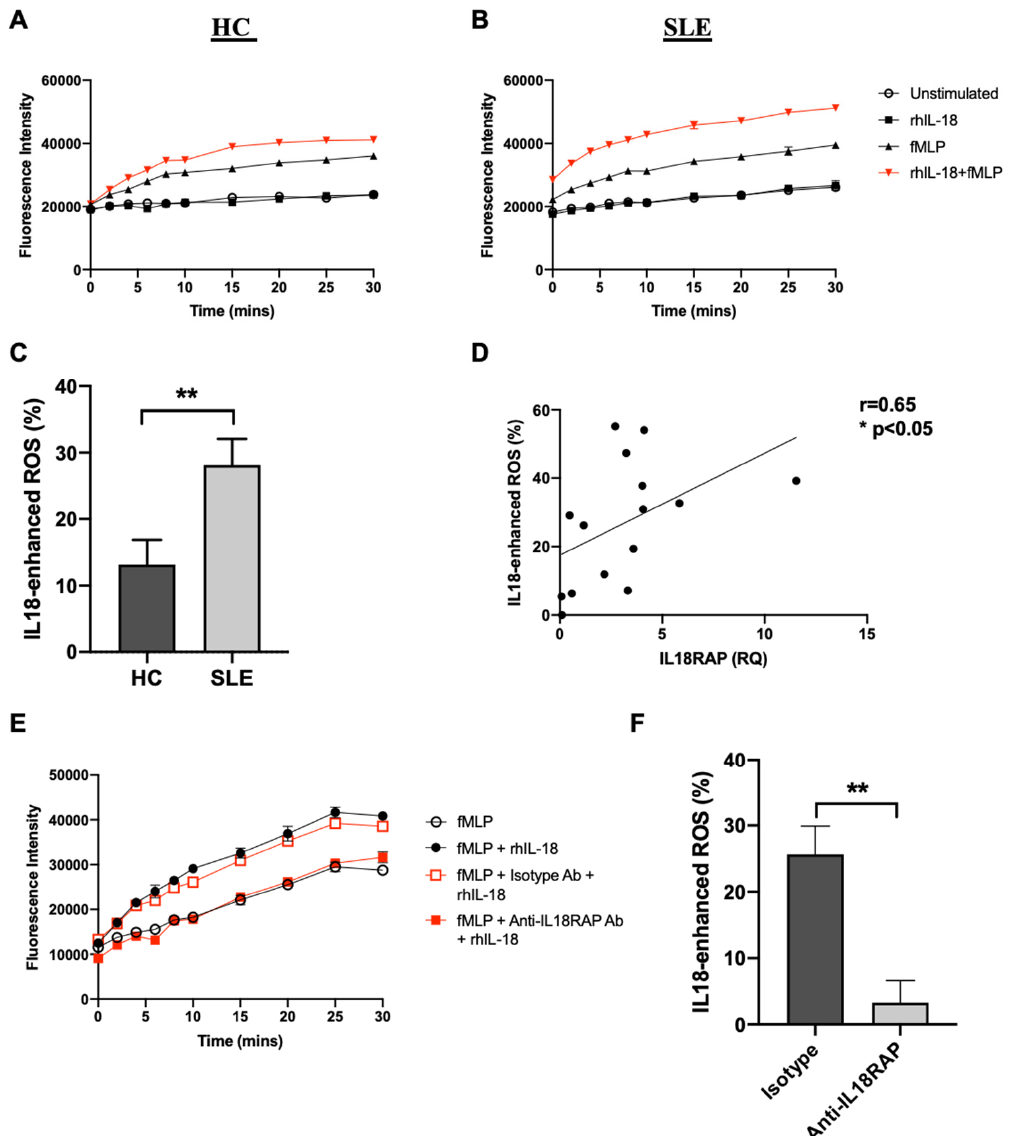
Figure 4. IL-18 enhances fMLP-mediated ROS generation in neutrophils via IL18RAP. Representative plots showing kinetics of ROS generation in neutrophils from ( A ) HC and ( B ) SLE patients upon treatment with or without rhIL-18 (100 ng/mL) and fMLP (100 nM) stimulation. ( C ) Summary chart showing IL-18-enhanced ROS generation in neutrophils at 30 min poststimulation in HC ( n = 14) and SLE patients ( n = 14). ** p < 0.01 by Mann–Whitney U test. ( D ) Correlation analysis between IL18RAP expression and IL-18-enhanced ROS generation using an independent set of HC and SLE neutrophil samples ( n = 15). * p < 0.05 by Spearman’s rank-order correlation test; r = correlation coefficient and the linear regression line is shown. ( E ) Representative plot showing fMLP-mediated ROS generation in SLE neutrophils with anti-IL18RAP antibody (Ab) or goat IgG isotype control (10 µ g/mL) pretreatment prior to IL-18 (100 ng/mL) stimulation. ( F ) Summary chart showing IL-18-enhanced ROS generation in SLE neutrophils ( n = 3) upon pretreatment with goat IgG isotype antibody or anti-L18RAP antibody at 30 min poststimulation. ** p < 0.05 by paired t test. Data shown as mean +